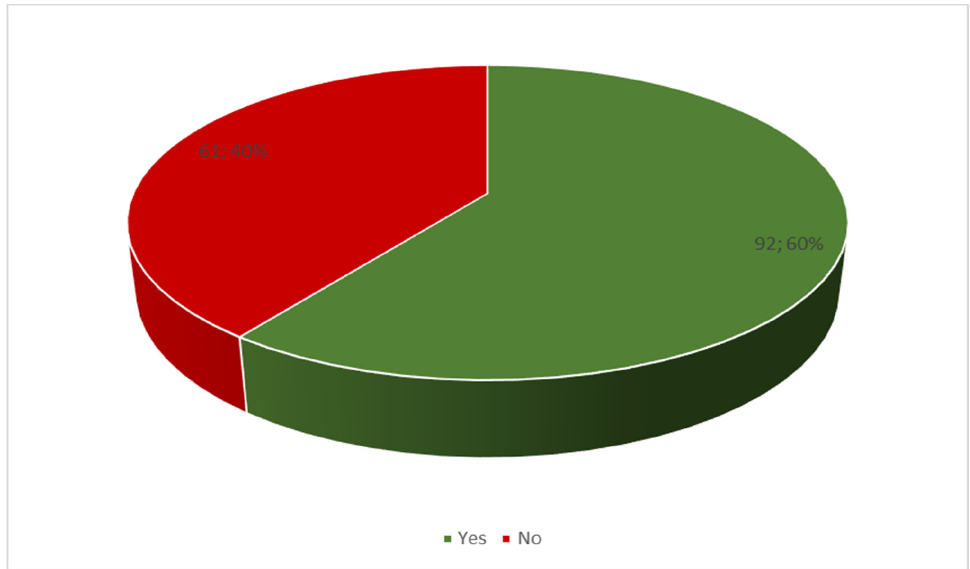
Figure 4. Distribution of responses to the question about crying in the presence of the child due to the child’s deteriorating health.